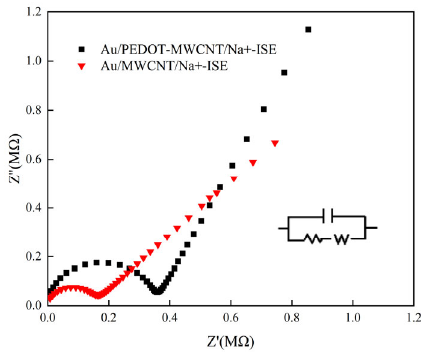
Figure 5. EIS of GC/POT − CB/K + − ISE and GC/CB/K + − ISE. The illustration is equivalent circuits of GC/POT − CB/K + − ISE.